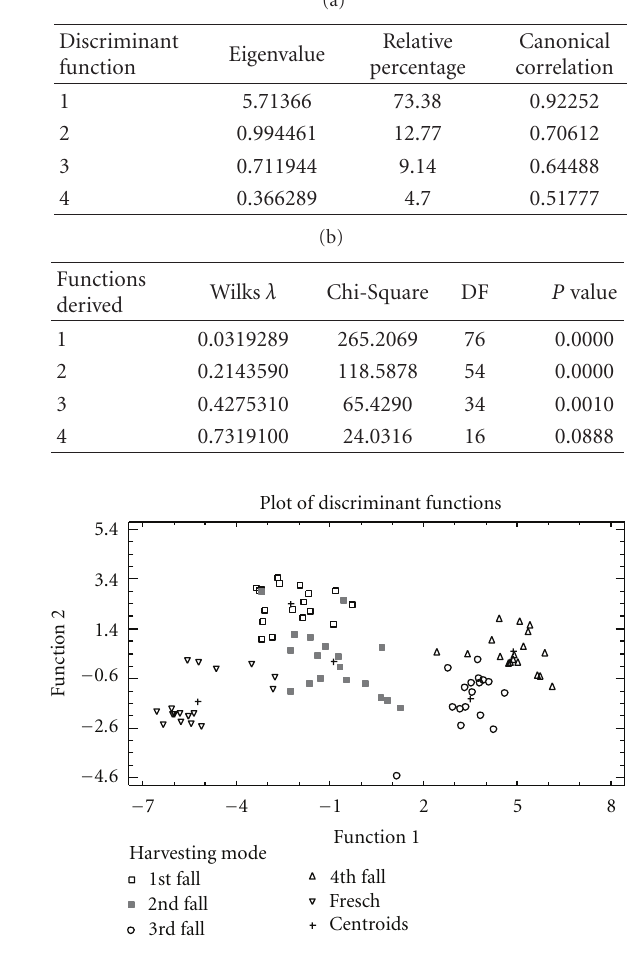
Figure 1: LDA plot for 90 olive oil samples (30 samples repeated three times) based on the concentration of 19 elements and using as input a priori five groups, that is, those corresponding to the olives harvested directly from the plants, called fresh, and those that have fallen naturally and stayed in contact with the soil irrigated with TWW. The moisture percentage of the olives were as follows: 50.73% ( ± 5.31%) called 1st fall; 33.45% ( ± 5.15%) called 2nd fall; 14.89% ( ± 2.62%) called 3rd fall; 4.22% ( ± 0.72%) called 4th